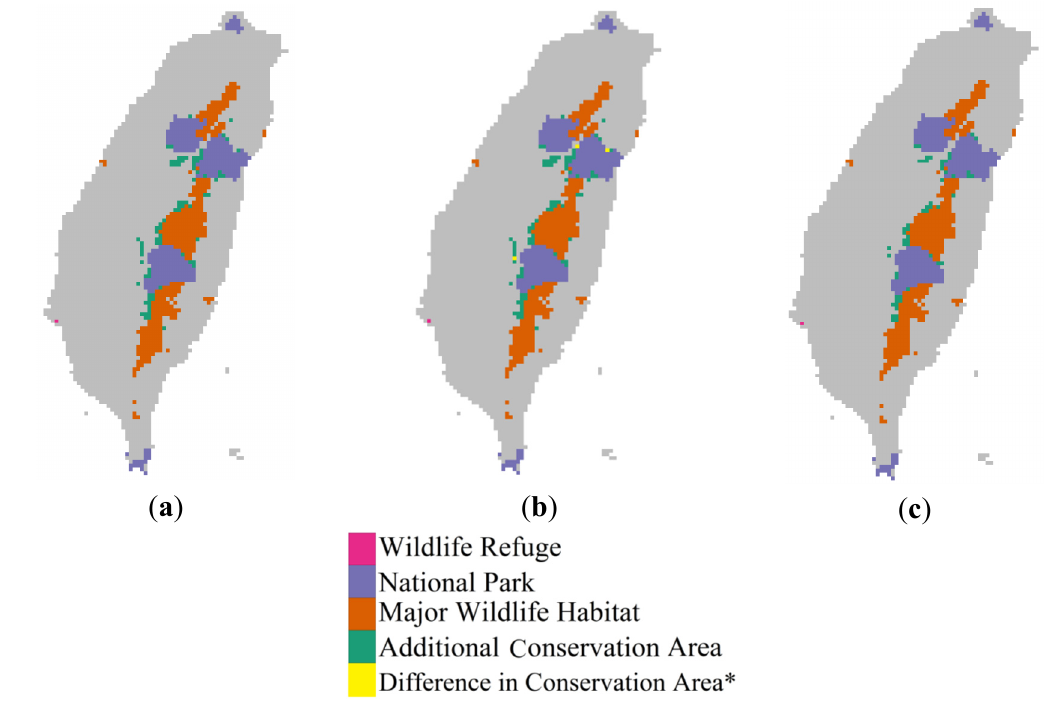
Figure 7. Current protected areas in Taiwan, including Wildlife Refuges, National Parks and Major Wildlife Habitats, and the additional areas determined by Zonation which are currently outside of existing protected areas: ( a ) under baseline; ( b ) all future climate scenarios (the extra conserved area under future climate scenario is the union of that under 15 future scenarios); and ( c ) future climate scenario (the worst scenario with the largest increase of temperature). Note: * The difference in additional conservation area between baseline and future climate scenarios. The period of future climate scenario is for